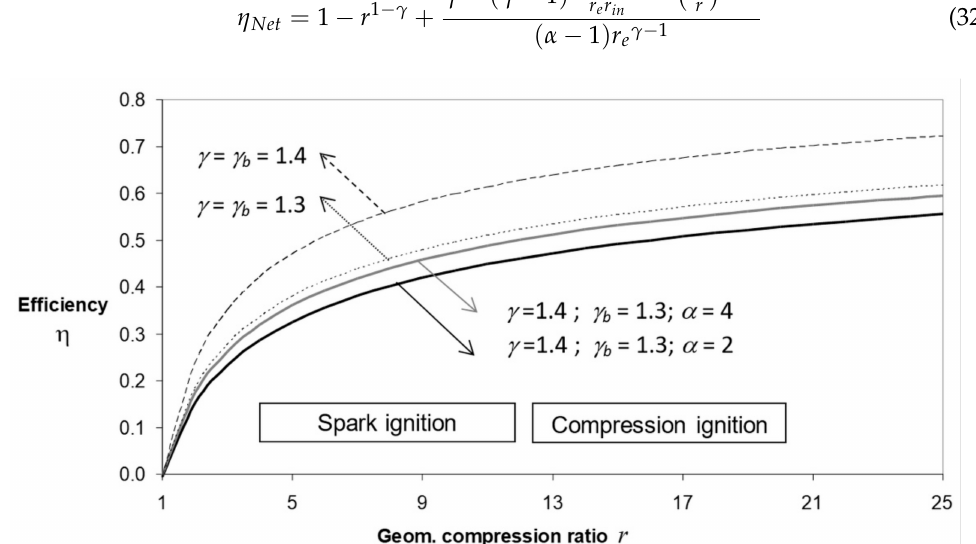
Figure 4. Effect of compression ratio and γ on cycles with constant γ and γ b , β = 1.0 (constant volume heat release) and r in = 1.0. r e = 0.85 r . Dashed lines correspond to cycles with γ = γ b , valid for α = 2 to 4. Typical ranges for r are shown for both types of